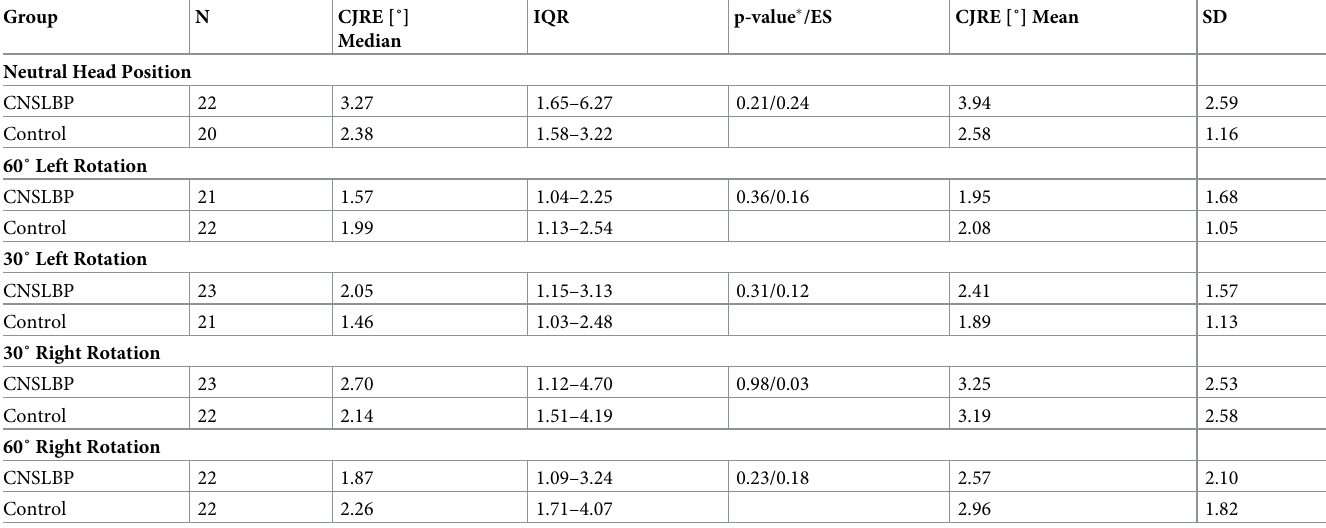
Table 3. Results of cervical joint repositioning error.